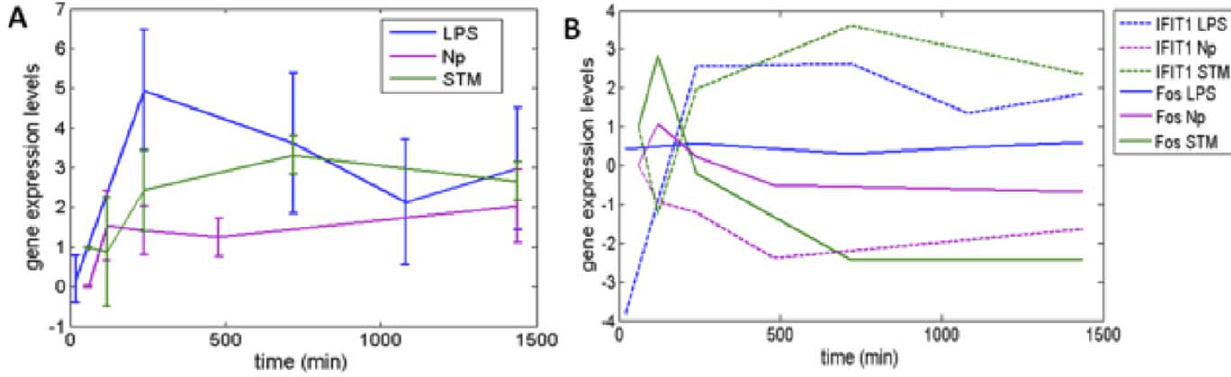
Figure 4. Dynamics of core response module. A) Temporal regulation of gene expression levels for a cluster of upregulated genes in the core response module. The three conditions LPS, Np (nanoparticle), and Salmonella (STM) are labeled with blue, purple, and green lines. Error bars signify 95% confidence and the average is over all gene expression profiles within a cluster. B) Individual gene expression levels of Ifit1 (dashed line) and Fos (solid line) under each condition LPS (blue), Np (purple), and STM